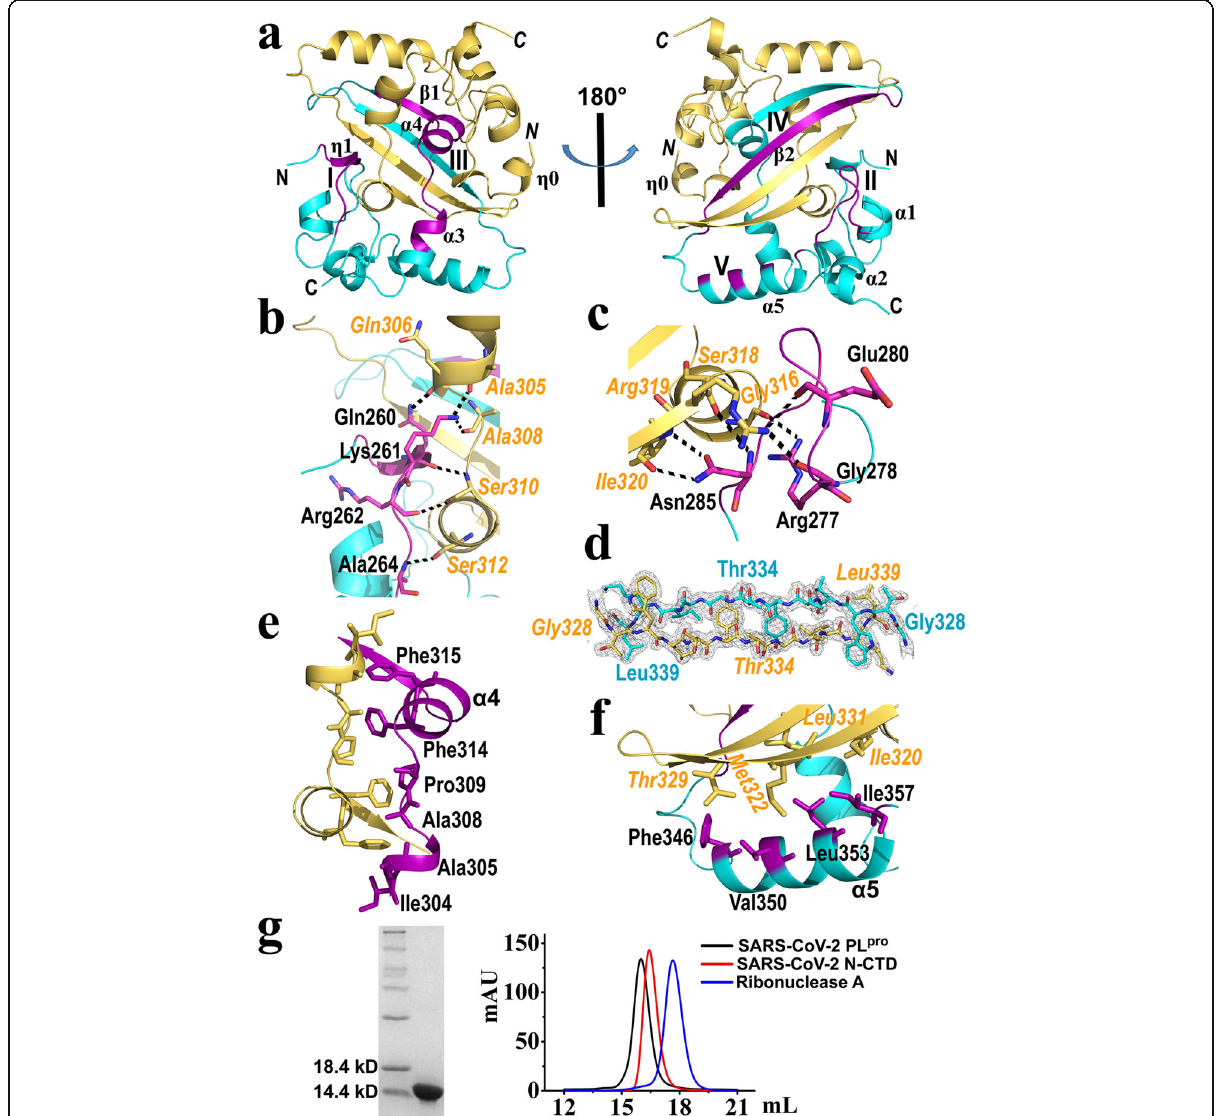
Fig. 2 Dimerization of the SARS-CoV-2 N-CTD. a Ribbon diagram of the N-CTD dimer. The overall structure of the dimer displays a rectangular slab with all helices at one side (left image) and the β -sheet at the opposite side (right image). Monomers A and B are depicted in cyan and yellow, respectively. The regions I and III for the N-CTD dimerization are marked in the left image while the regions II , IV and V are indicated in the right one. N- and C- termini of subunit A and B (in italics) are labelled. b The hydrogen-bond network in region I for the N-CTD dimerization. Residues in protomer A are marked in black, while residues from subunit B are labelled in italics in orange. c The hydrogen-bond network in region II for the N-CTD dimerization. d The 2Fo-Fc electron density (gray, 1.5 σ ) of the β 2 strands (residue Gly328-Leu339; region IV ) of both subunits. Residues (N- and C- termini) of the β 2 are labelled. The non-conserved residue Thr334 is also marked. e and f The conserved hydrophobic cores in region III and V for the N-CTD dimerization. g Analytical gel filtration assay was performed. The molecular mass of the SARS-CoV-2 N-CTD is ~ 13.4 kD, which is identified by the SDS-PAGE (left image). In the gel filtration assay, the N-CTD is shown as a dimer in solution (right image). Ribonuclease A (blue line; Sangon Biotech, China): ~ 13.7 kD. SARS-CoV-2 papain-like protease (PL pro ; black line): ~ 35.5 kD. The peak position of N-CTD (red line) is corresponding to ~ 29.8 kD, representing a dimer of N-CTD (theoretical molecular mass is ~ 26.7 kD). Figures a-f were made by the program PyMOL